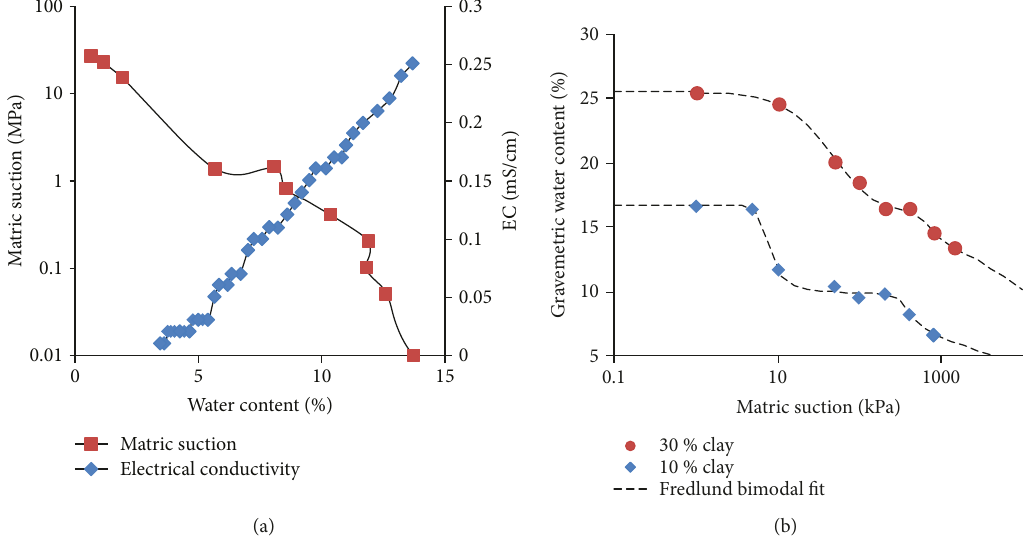
Figure 7: (a) Matric suction and electrical conductivity versus water content for 15%-clay sand mixture. b Soil water characteristic curve of sand-clay